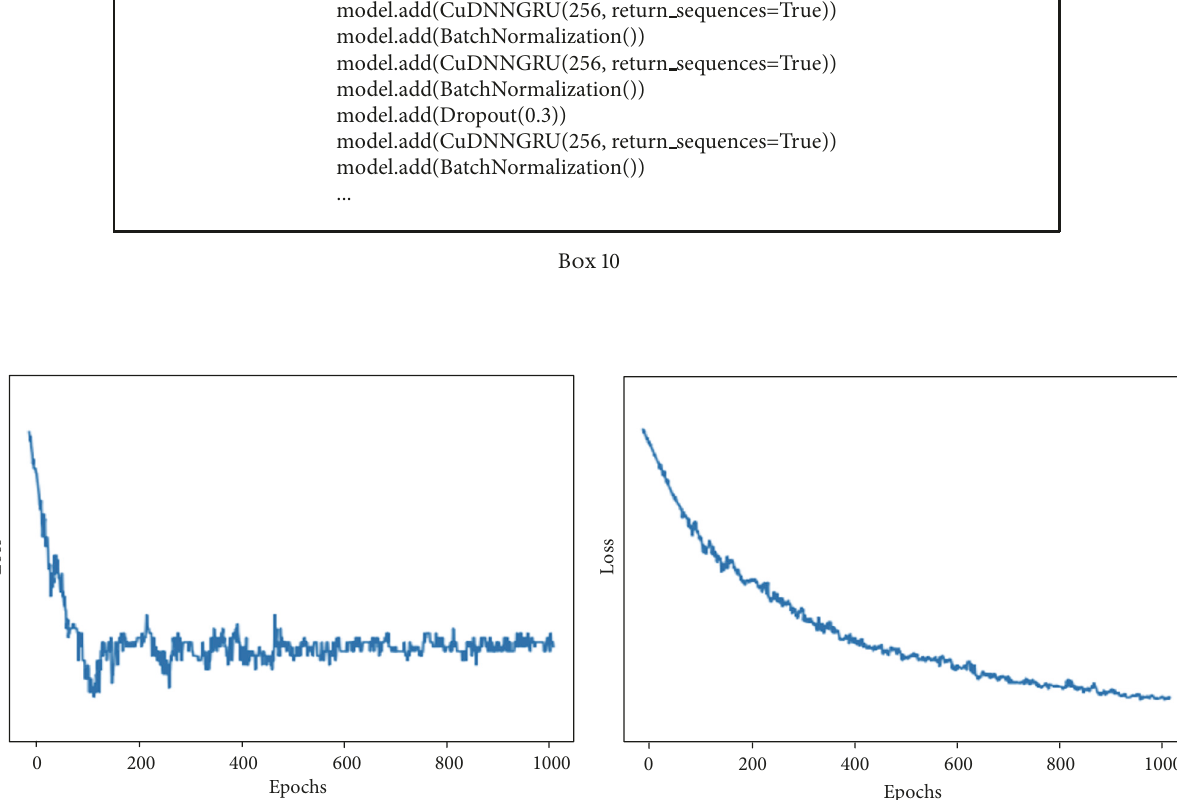
Figure 2: Training and testing graphics for XGBoost.